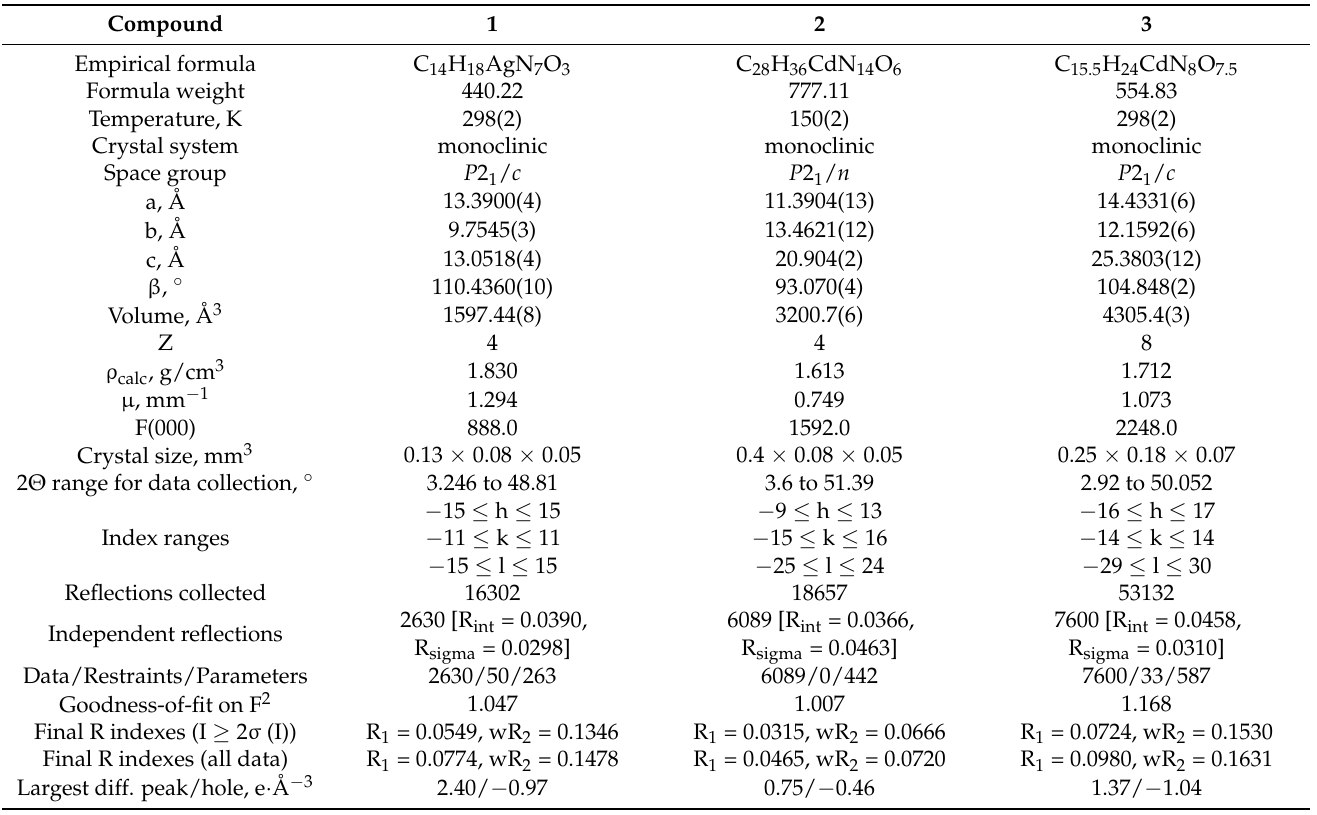
Table 1. Crystallographic data of the compounds 1 – 3 .